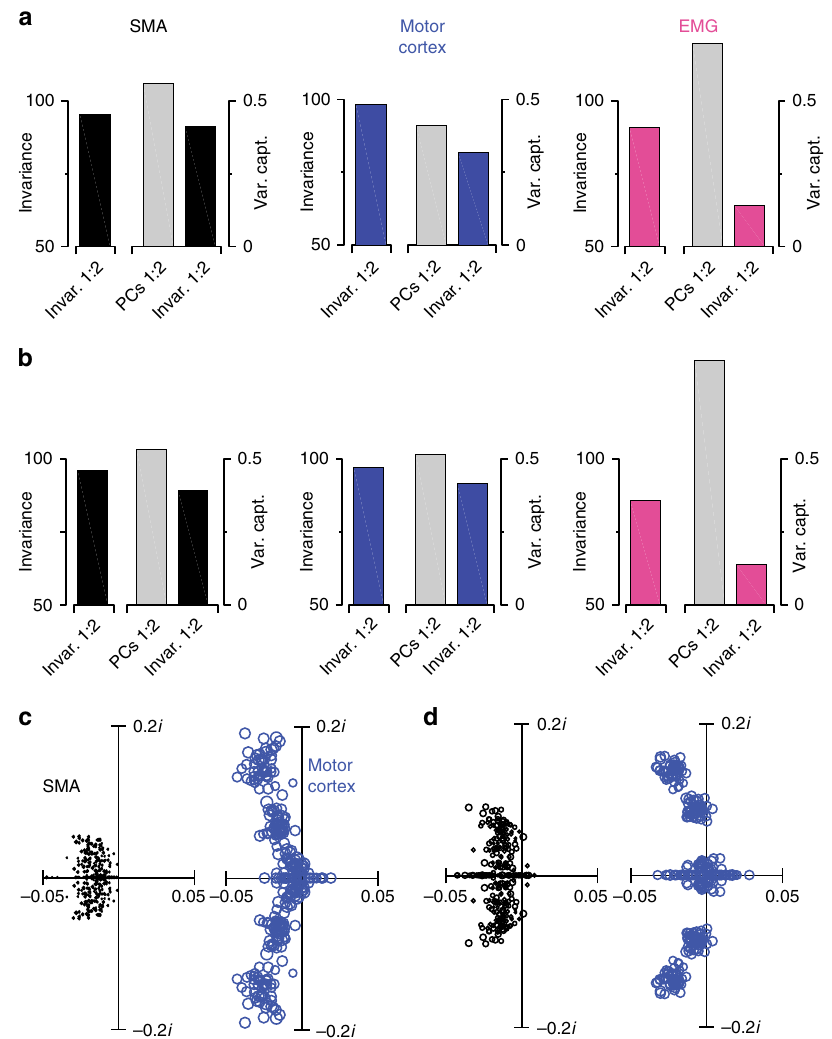
Fig. 7 Quanti fi cation of HDR-based condition-invariant structure and PCA-based dynamical structure. a Quanti fi cation of the structure captured by the condition-invariant dimensions. In each subpanel, the leftmost bar indicates the empirical condition invariance of activity in the condition-invariant dimensions. The right plot indicates the total data variance captured by the two condition-invariant dimensions and that captured by the fi rst two PCs (gray bar). These analyses focus on the time from − 100 ms before movement onset until 200 ms after movement onset. This is the epoch during which the signal in the condition-invariant dimensions was changing rapidly. Data are for monkey Ba. b Same as a but for monkey Ax. c Eigenvalue spectra when fi tting linear dynamics to the population response projected onto the top six principal components (PCs), rather than using HDR. The analysis was conducted for 100 bootstrap repetitions, each time re-drawing a new population of neurons (with replacement) from the recorded population. Fitting linear dynamics resulted in a set of six eigenvalues per bootstrap repetition. For visualization, only the fi rst 50 sets of eigenvalues are shown. Circle sizes are proportional to fi t quality. Data are for monkey Ba. d . Same analysis for monkey